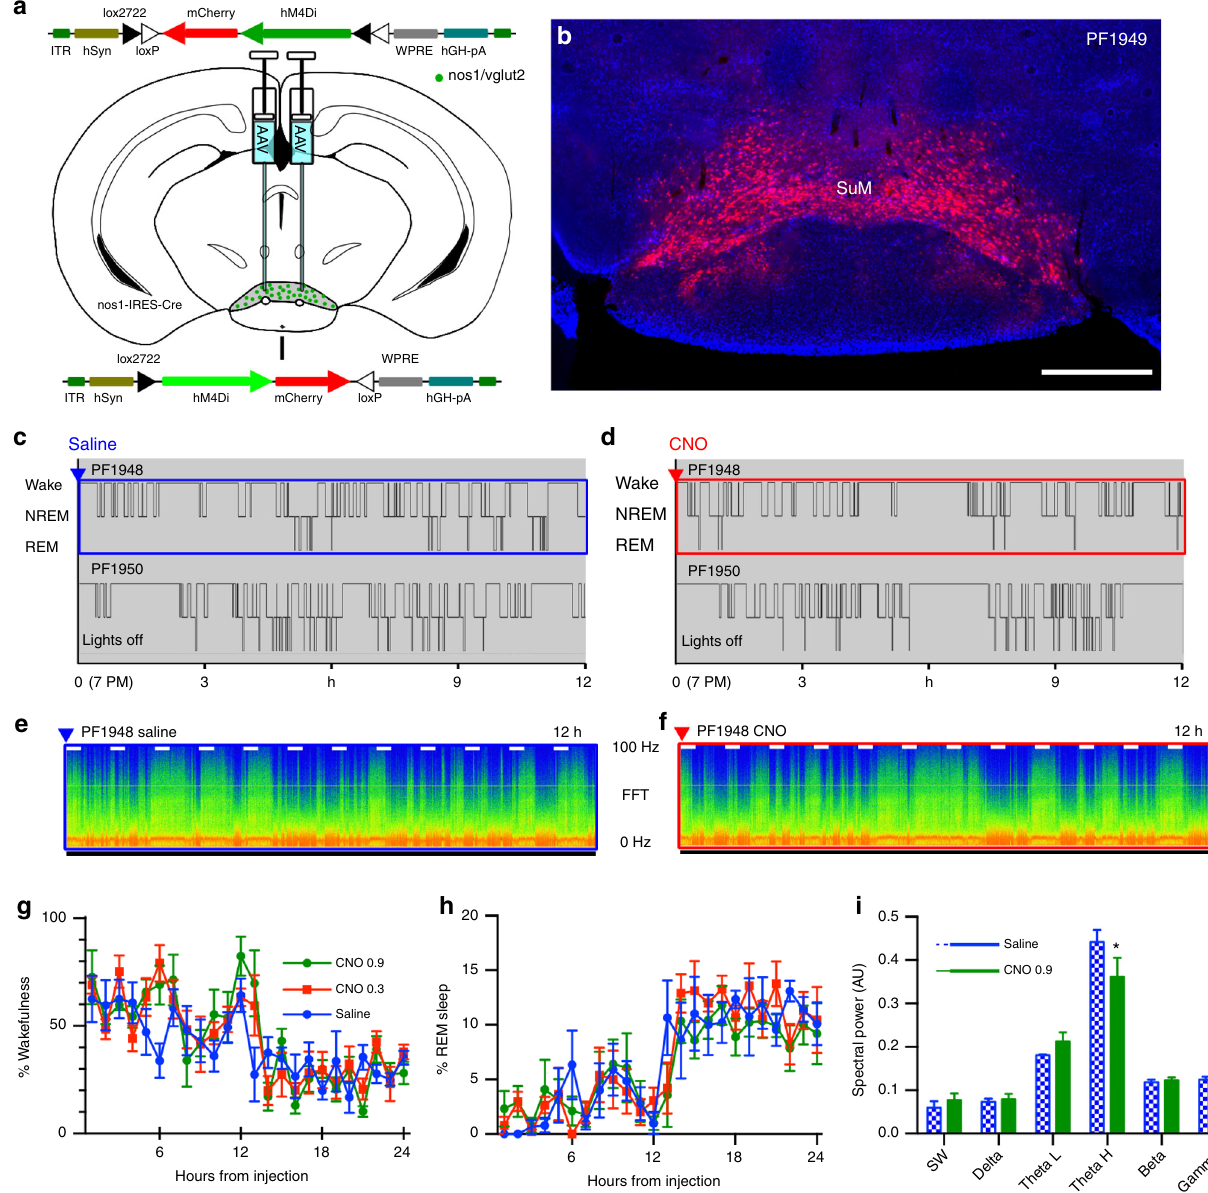
Fig. 8 Inhibition of SuM Nos1 does not cause somnolence, but reduces REM theta activity. a Cartoon showing AAV-FLEX-hM4Di-mCherry recombining in Nos1 neurons that express Cre. b Conditional transduction of inhibitory hM4Di in Nos1-IRES-Cre mice (mCherry fl uorescence with DAPI counterstain; scale bar 500 µ m). c , d Hypnograms from two mice over 12 h after vehicle and CNO 0.9 mg/kg injected at ZT12 (7 PM, lights-off). Unlike inhibition of all glutamate neurons (Fig. 4), the hypnograms appeared similar regardless of treatment. e , f CSA after vehicle and CNO from the periods shown by the blue and red boxes, respectively, in c and d (0 − 100 Hz, black bar shows the dark period, short white bars represent 20 min and are spaced 1 h apart). g , h There is no change in the amount of wakefulness, NREM or REM sleep (separate two-way ANOVA, wake, REM, and NREM: F (2, 192) = 1.709, 0.8381, 2.04; p = 0.1837, 0.4341, 0.1329, respectively, n = 5). i Power spectra (band mean ± SEM) were only changed for REM sleep in post hoc comparisons, with a signi fi cant suppression of waking high theta activity (Bonferroni * p = 0.0332, all other bands p > 0.9999, n = 3, t = 3.048, df = After additional TBS rinses, sections were incubated for 30 min in 1% blocking Data analysis . Physiological Data Analysis was performed with Spike 2 (version reagent (Roche, cat#11 096 176 001) then overnight in peroxidise conjugated 8.05, Cambridge Electronic Design, UK) using the Ratsleepauto script (version anti-digoxigenin antibody (1:500; Roche cat#11 207 733 910). Sections were rinsed 2.02, Cambridge Electronic Design), with complete manual rescoring to correct any in TBS then reacted with 1:50 Tyramide signal ampli fi cation fl uorsent kit (TSA errors. Compressed spectral arrays were created by use of the sonogram feature of Plus-A-Cy3, Perkin Elmer cat#NEL744001KT) diluted in ampli fi cation diluent Spike 2 (settings 32768 points, Hanning window). Images of sonograms were (30 min). imported into FIJI (ImageJ 2.0.0, NIH) despeckled before transfer to Inkscape To determine neuronal size, one high power fi eld of the SuM, immediately (version 0.91) for fi gure creation. Spectral data for comparison of discrete spectral above the mammillothalamic tract before it emerges dorsally through the bands was performed by ‘ Ratsleepauto ’ script with 1024 points per Hanning mammillary capsule was use to compare the size of SuM vgat/vglut2 and SuM vglut2 window, saved as text and imported to Excel where 60Hz artifact was removed by neurons. Neurons with clear nuclei and unambiguously distinguishable from interpolation of points from 59.5 to 60.5Hz, and spectral values were added into adjacent neurons were included and measured through their long axis. Student ’ s t - test was used for parametric two-tailed comparison.